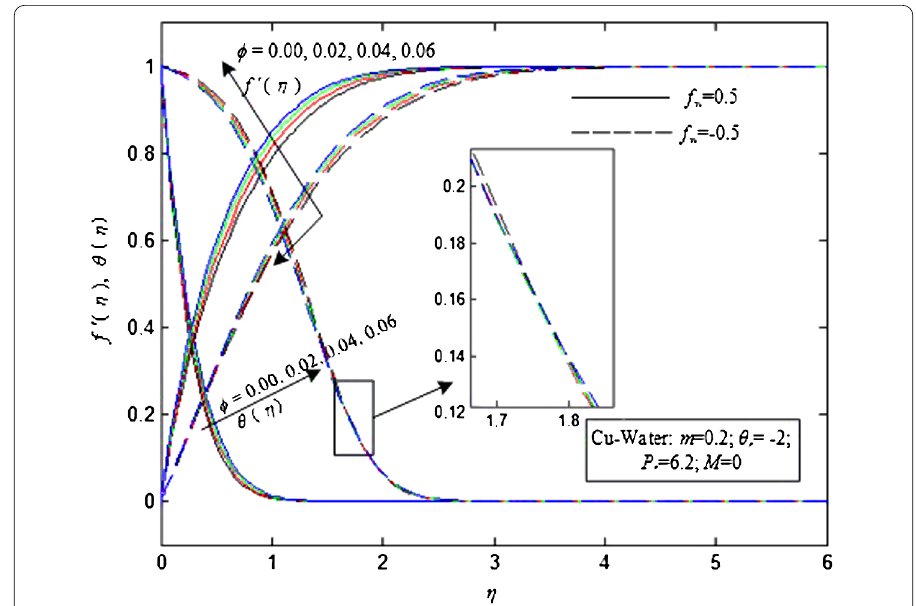
Figure 6 Velocity and temperature profiles of Cu-Water nanofluid for representative values of φ with different f w .